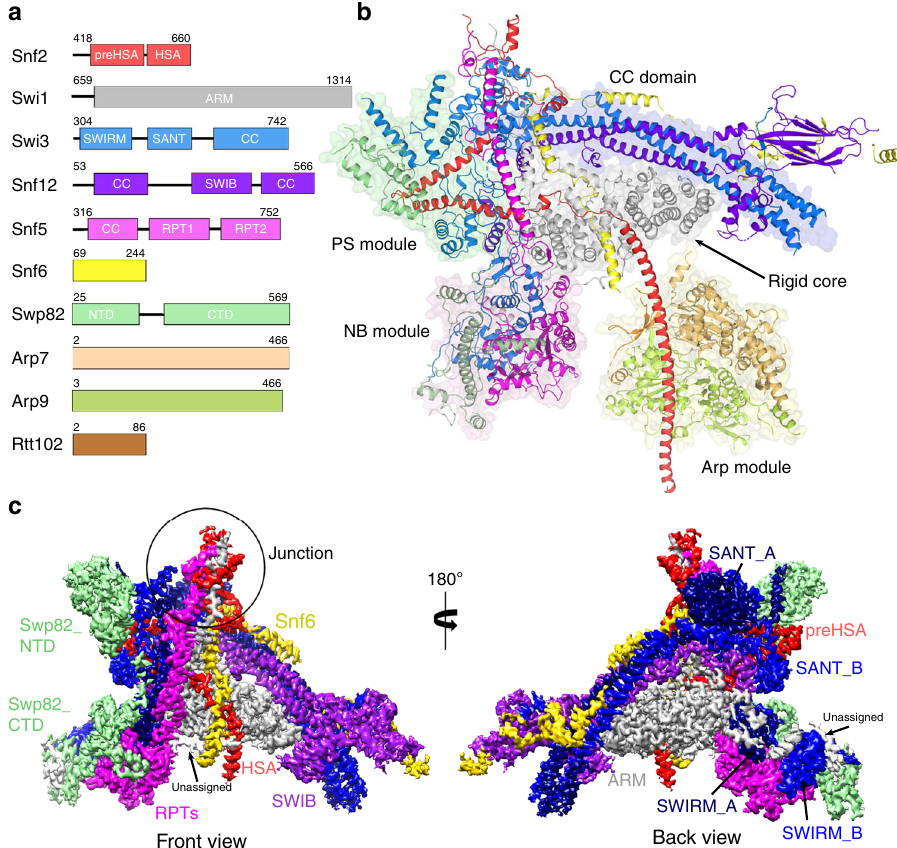
Fig. 1 Overall structure of the yeast Swi/Snf complex in the nucleosome-free state. a Domain organization of all subunits that are included in the fi nal model. b Cartoon model of the Swi/Snf complex with the individual subunits colored. The rigid core, PS module, NB module, CC domain, and Arp module are colored in gray, green, pink, and orange, respectively. c Front (above) and back (below) views of the cryo-EM composite map of the base module locally re fi ned to 2.9 Å. The chain A of Swi3 is colored in deep blue while the chain B is colored in bright